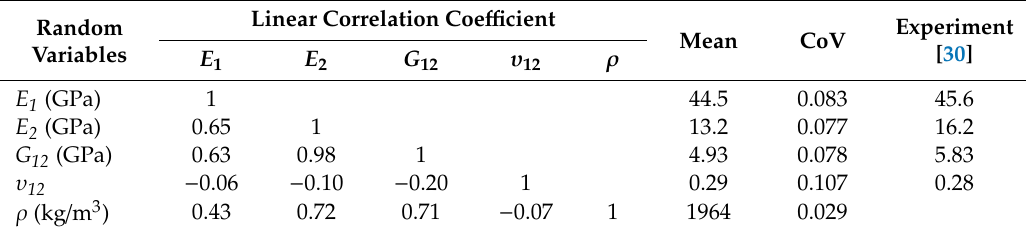
Table 2. The statistics of UD E-glass / Epoxy composite.